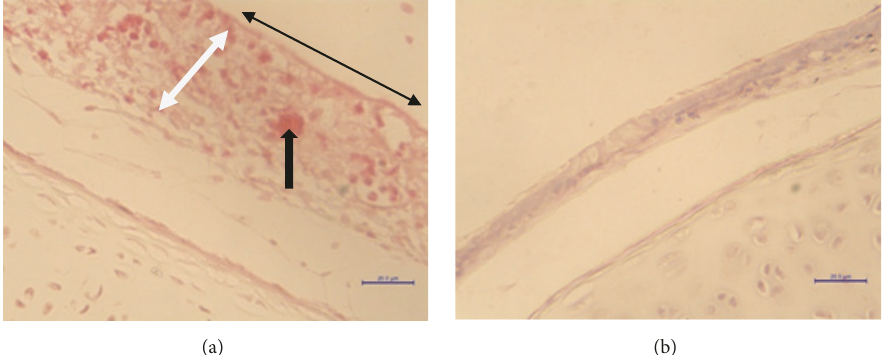
Figure1:TracheaofSPFchickens.(a)Day3piofvNDV.Hyperaemia(blackarrow),hyperplasia(whitedoublearrow),anddeciliation(double arrow in black), lesion scoring of 4.00.Scale bar = 20 𝜇 m. (b) Control group, lesion scoring of 0. Scale bar = 20 𝜇 m.